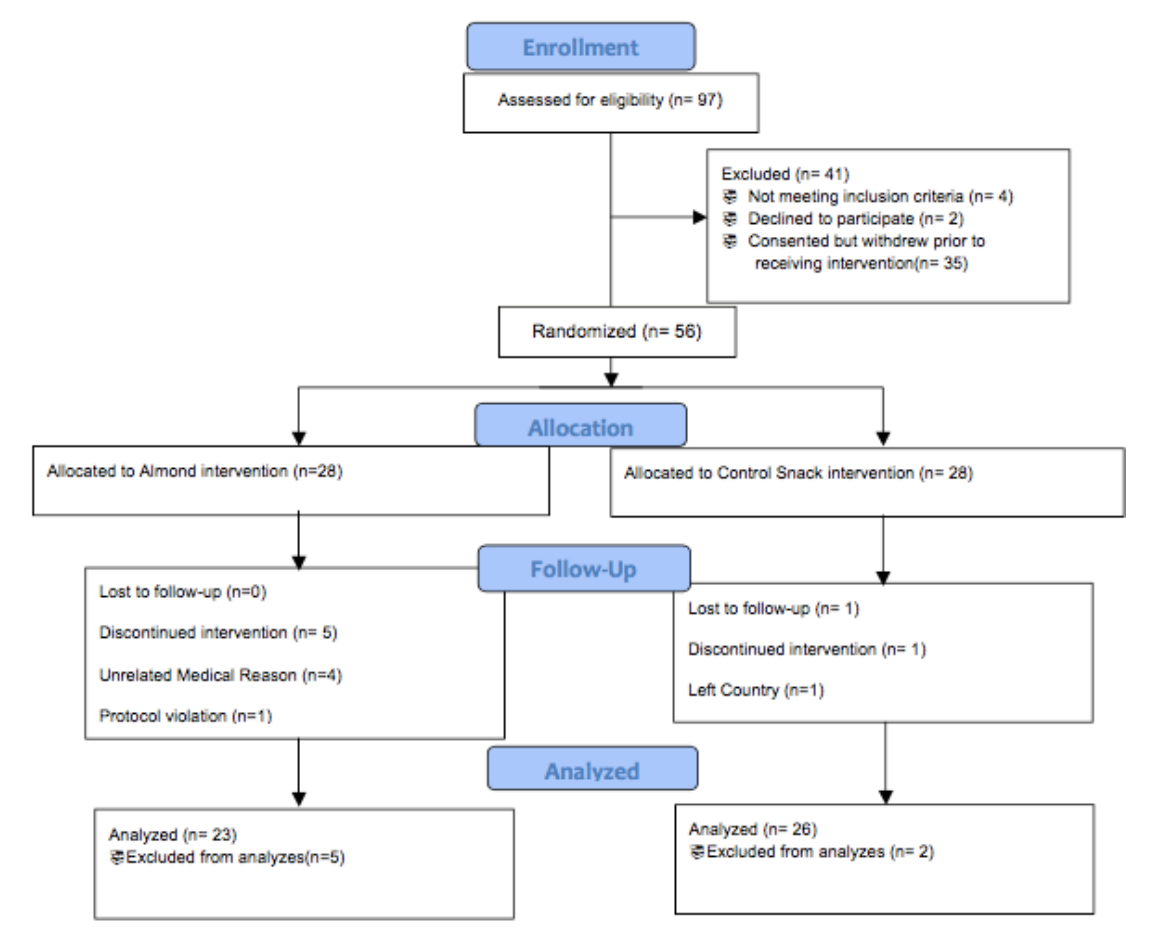
Figure 1. CONSORT (Consolidated Standards of Reporting Trials) flow diagram.